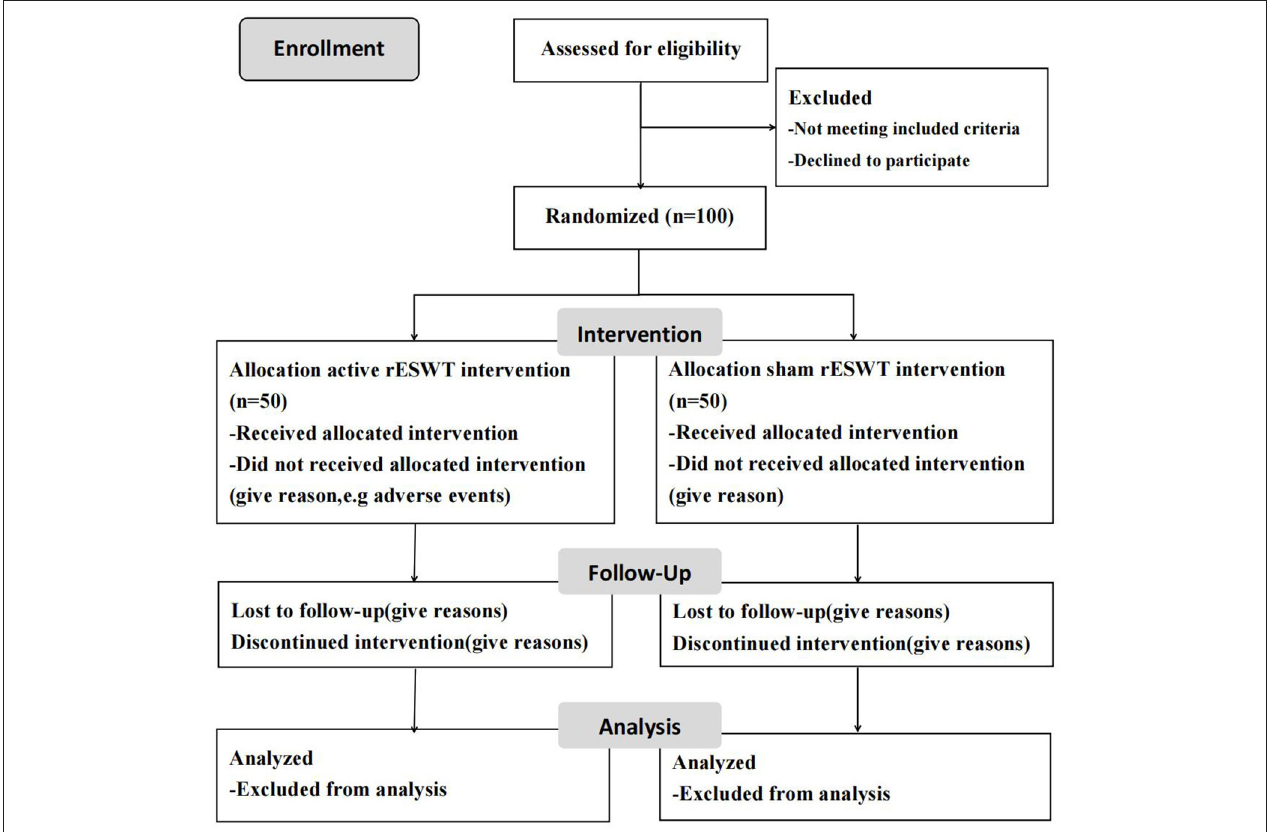
FIGURE 1 | CONSORT flow diagram of